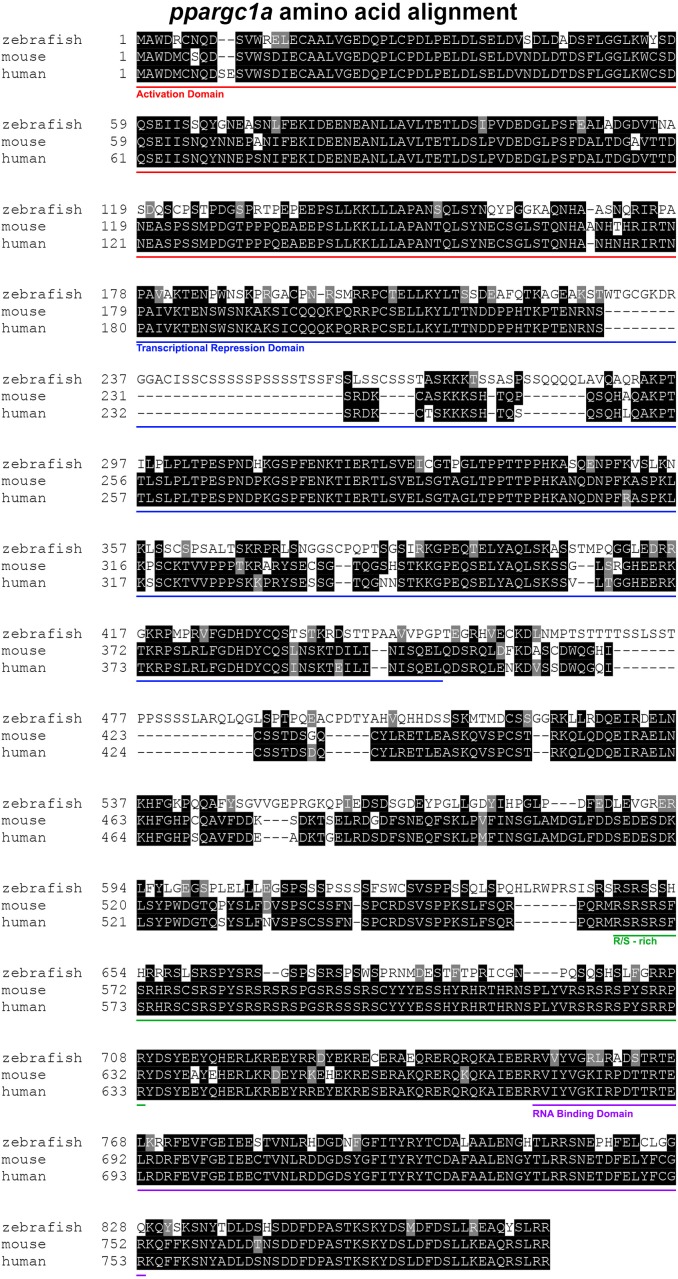
ppargc1a is conserved across vertebrate species.Sequence alignment illustration of zebrafish (top), mouse (middle), and human Ppargc1a amino acids. Black background indicates conservation among species. Conserved protein functional domains are indicated with color labeling and lines to demarcate their locales.